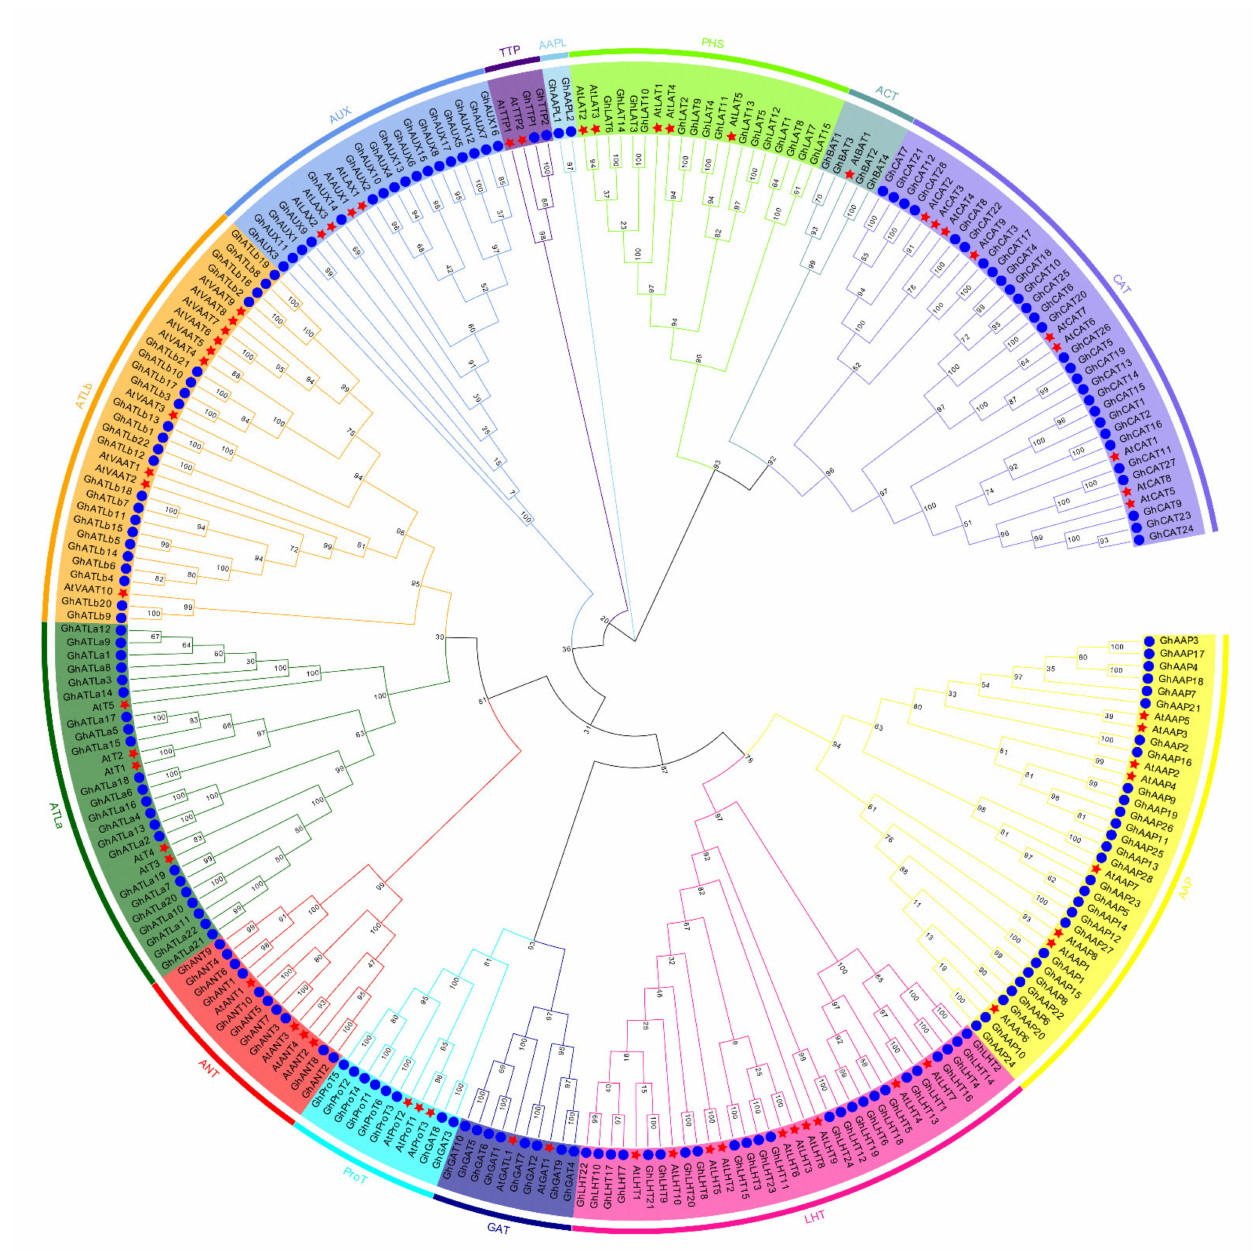
Figure 1. Phylogenetic tree of GhAAT ( G. hirsutum L. AAT) and AtAAT ( A. thaliana AAT) proteins. 190 GhAATs from G. hirsutum L. marked by red pentagrams and 63 AtAATs from A. thaliana marked by blue cycle. The phylogenetic tree was generated using MEGAX via the maximum likelihood (ML) method with 1000 bootstrap replicates. All 190 GhAATs and 63 AtAATs were divided into 13 subgroups which were highlighted by different colors (AAP, LHT, GAT, ProT, AUX, ATLa, ANT, ATLb, AAPL, TTP, PHS, ACT, and